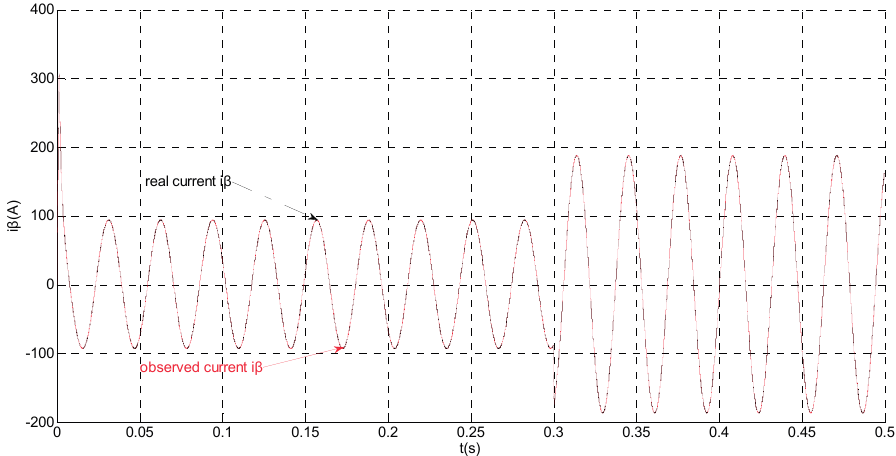
Figure 5. Simulation results of the actual and observation of α axis stator current.